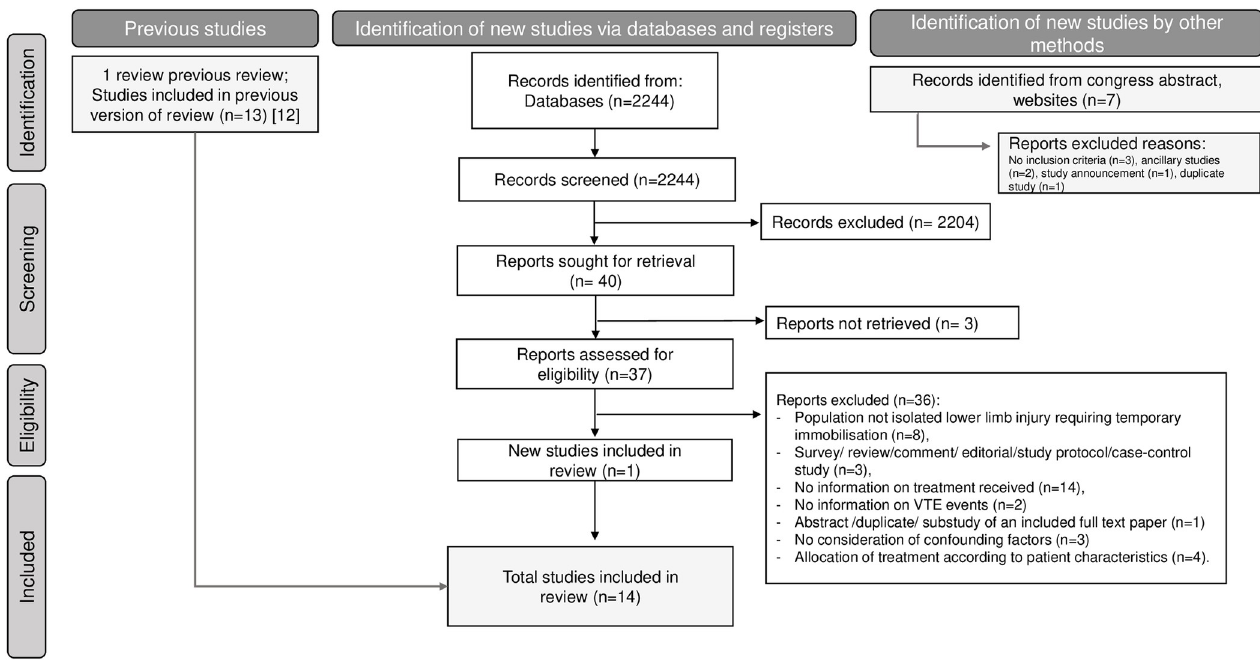
Fig 1. PRISMA flow